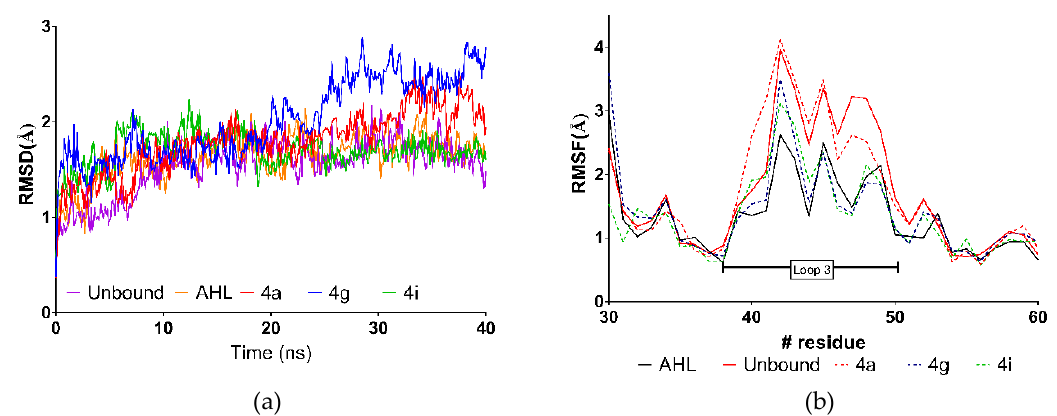
Figure 6. ( a ) RMSD along simulation time plot and ( b ) RMSF of residues of Loop 3 plots generated from data from MD simulations of complexes of 4a , 4g , and 4i with LasR.